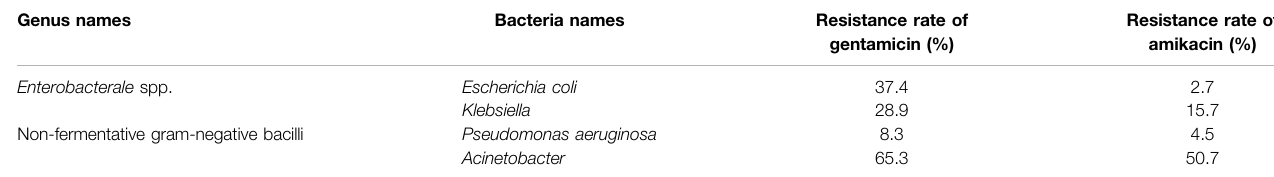
TABLE 2 | Resistance rates of common gram-negative bacilli to gentamicin and